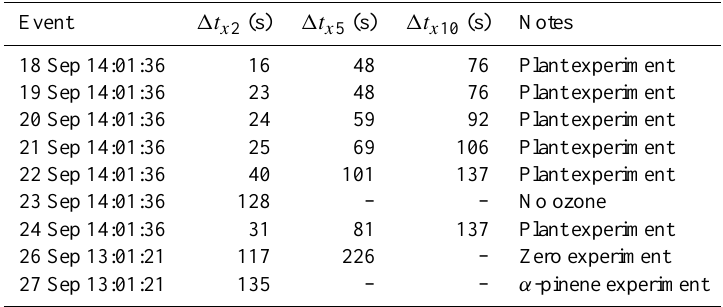
Table 1. Overview of the particle formation experiments performed, as well as the time delay between lighting the UV light and observing a concentration increase, measured by the PSM